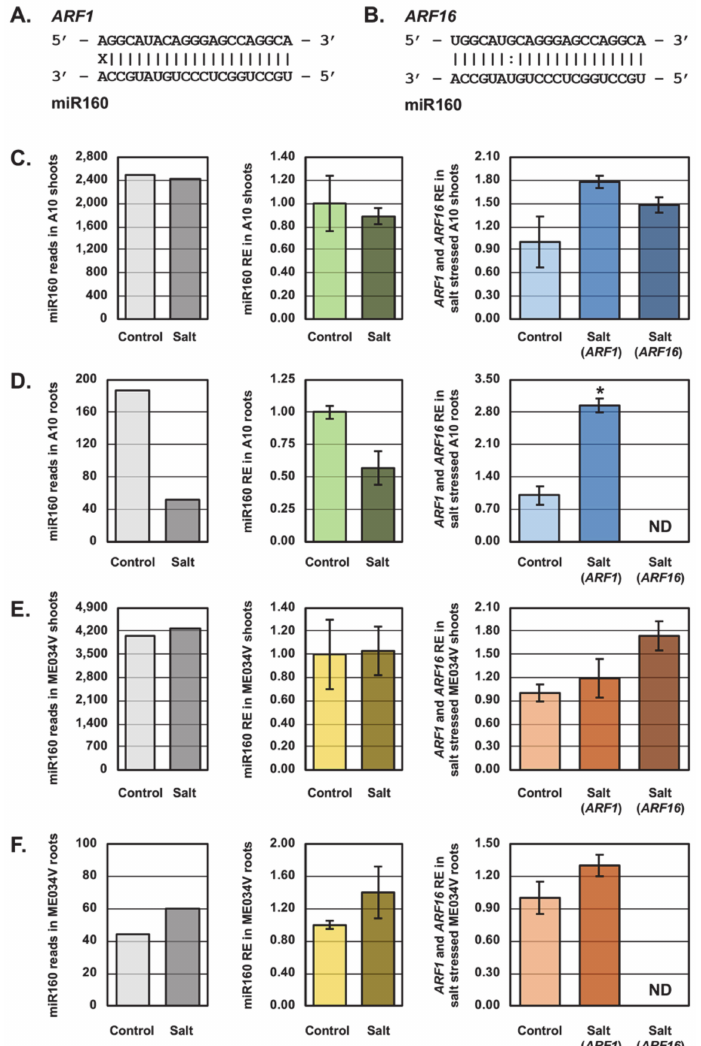
Figure 5. Molecular assessment of the response of the miR160 regulatory module to salt stress. Alignment of the S. viridis miR160 sRNA sequence to the putative target sequences harbored by the S. viridis ARF1 ( A ) and ARF16 ( B ) transcripts. RT-qPCR confirmation of the abundance of the